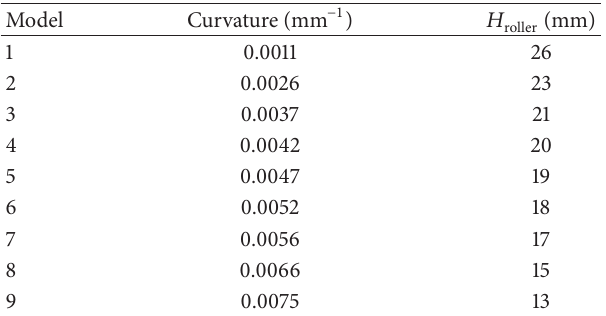
Table 1: Curvature and height of the nine rollers used in the